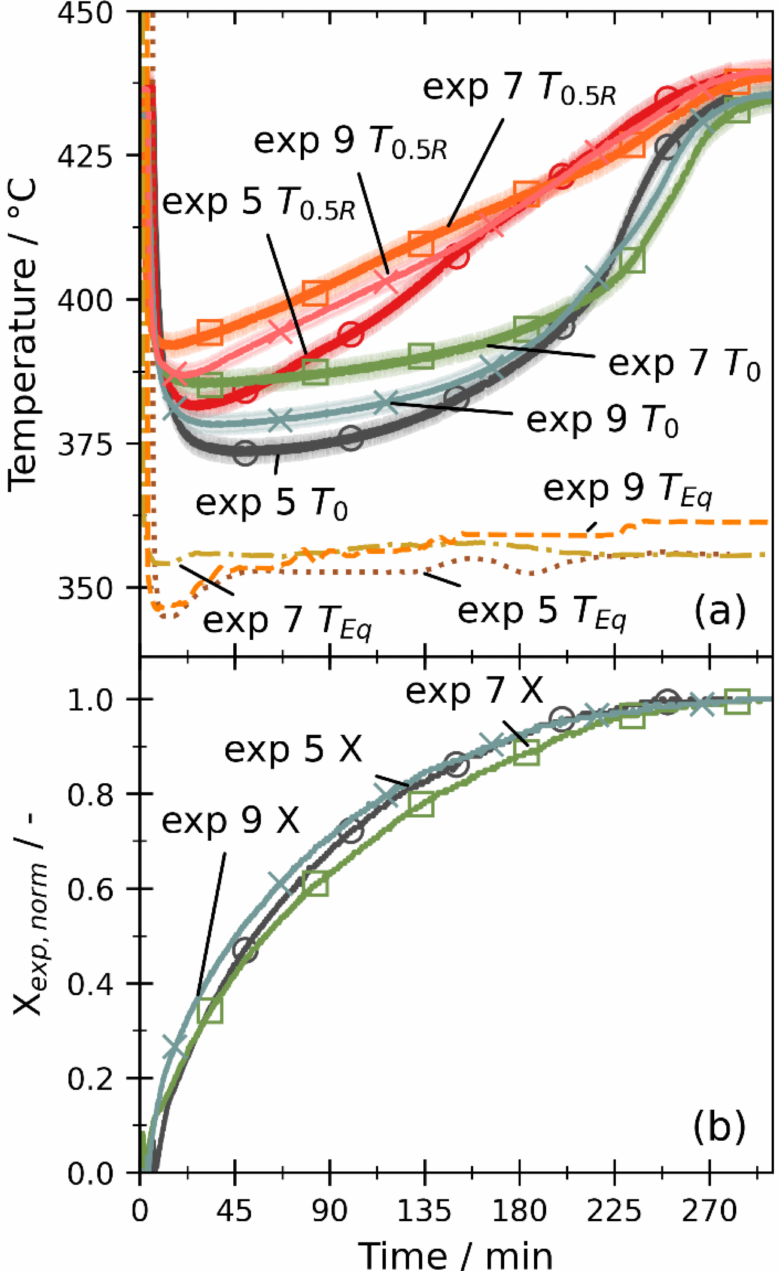
Figure 9. Comparison of three experiments (E5, E7, E9) with similar pressures and the same heater temperature of 450 ◦ C. Experimental and numerical results of temperatures ( a ) and conversions ( b